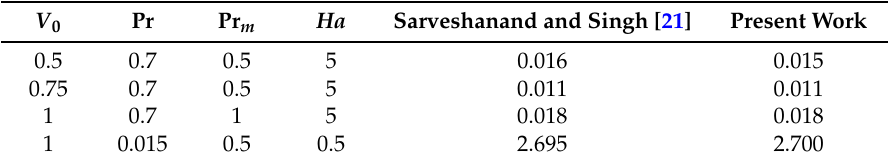
Table 3. Comparison of skin friction tension over the upper wall between the present results